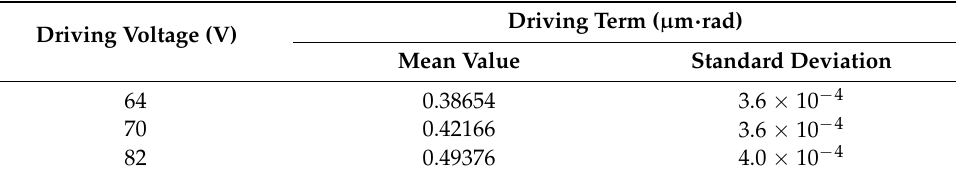
Table 1. Mean value and standard deviation of the driving term.